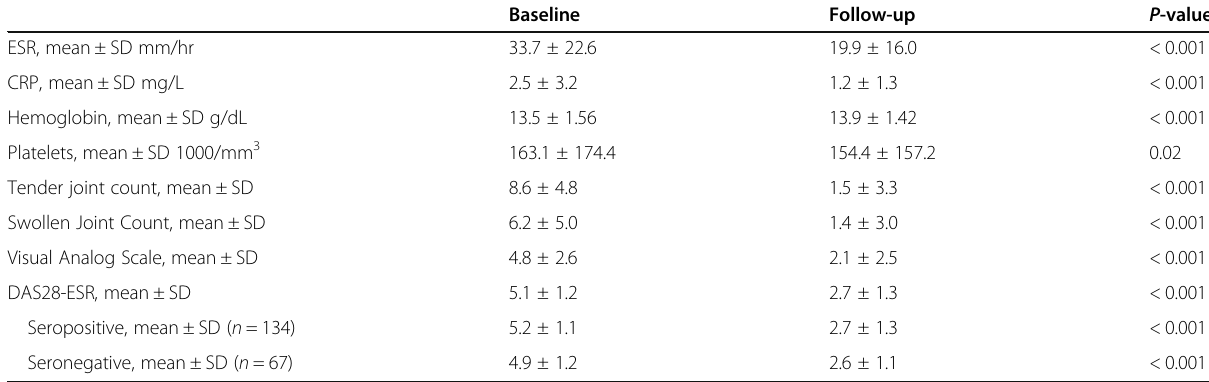
Table 2 Response rate of disease activity measurements